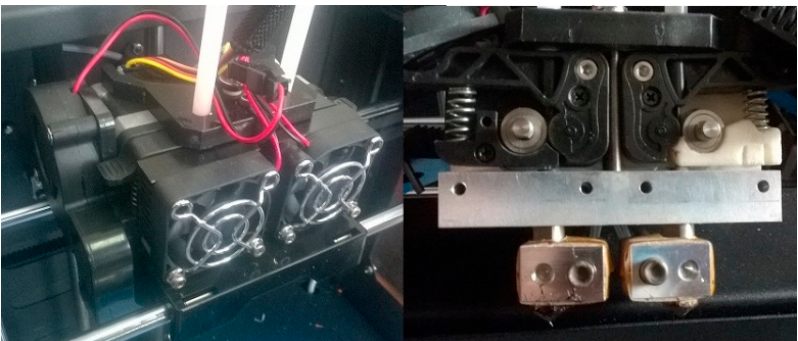
Figure 3. QidiTech Avatar IV dual extrusion system.